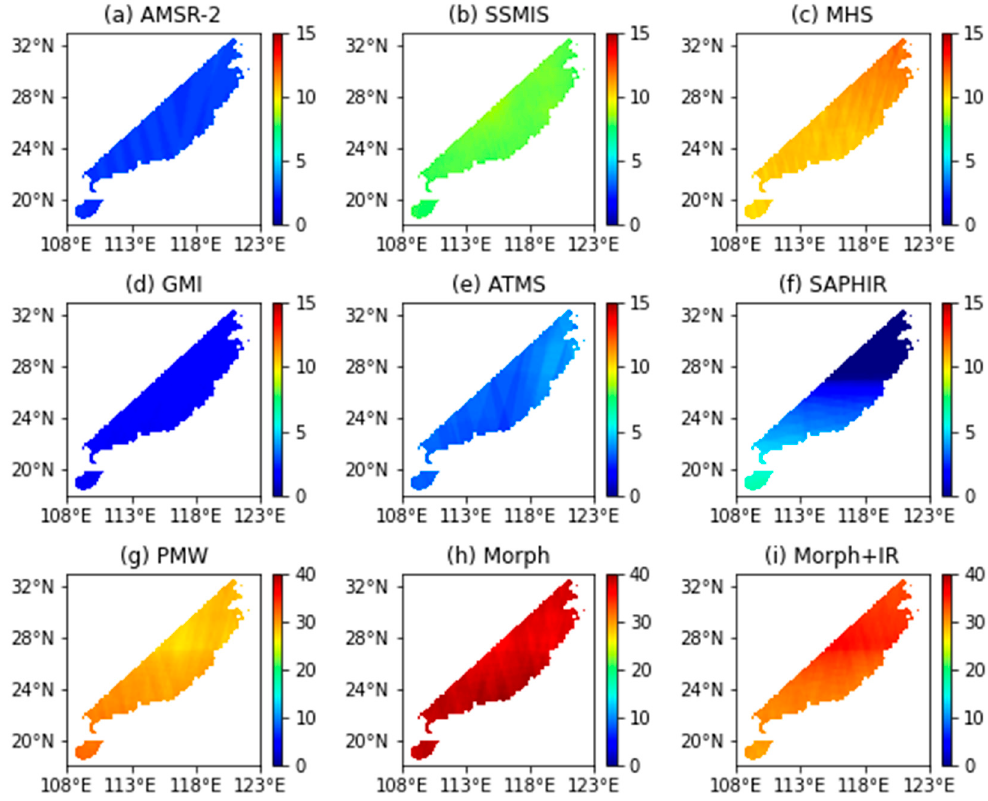
Figure 3. Spatial distributions of sampling frequency for nine categories in percentage, containing ( a – f ) six PMW sensors, ( g ) merged PMW, ( h ) morphed PMW, and ( i ) the mixture of morphing PMW and Infrared (IR).